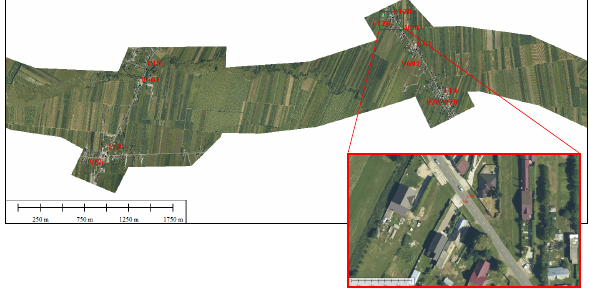
Figure 22 . Improved orthophoto plans from Open Skies images georeferenced with the aerotriangulation orientation